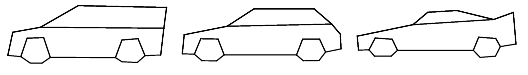
Figure 3. 3D Active Shape Models. Centre: mean shape, γ = (0 , 0) , left: γ l = (1 . 0 , 0 . 8) , right: γ r = ( − 1 . 0 , − 0 . 8)